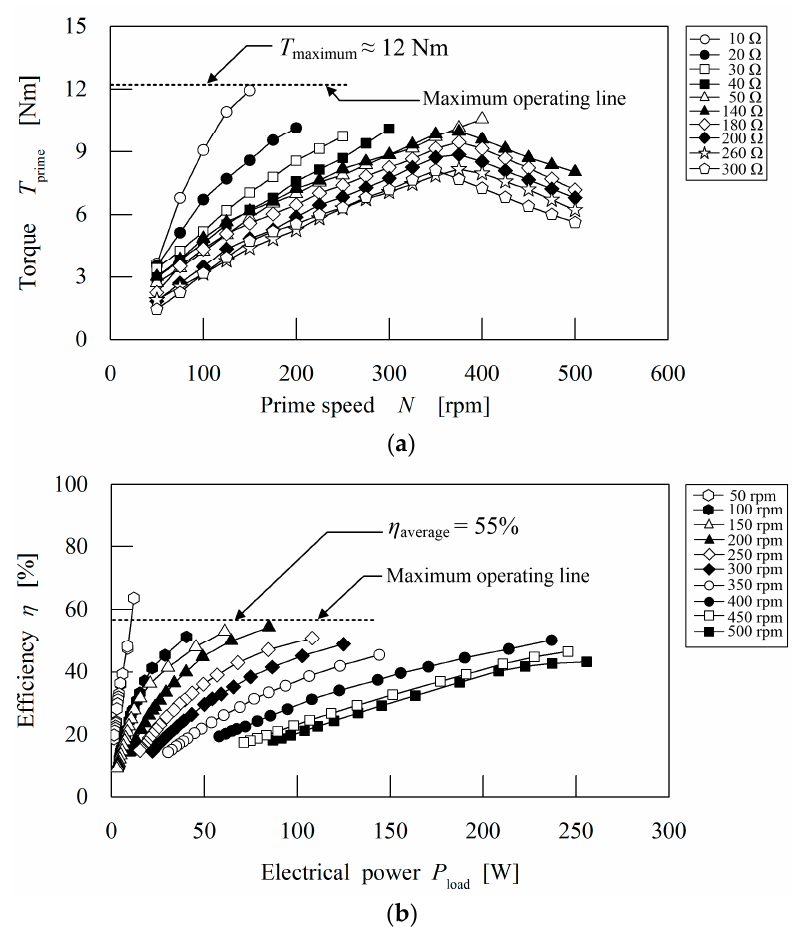
Figure 13. Measured torque and efficiency vs. speed/electrical power characteristics at various loads: ( a ) Torque vs. speed; ( b ) Efficiency vs. electrical power.